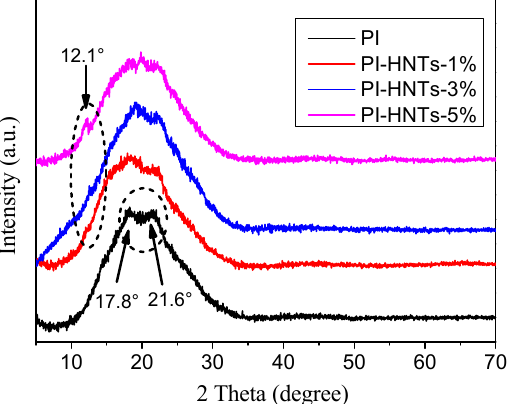
Figure 6. XRD patterns of PI, PI-HNTs-1%, PI-HNTs-3% and PI-HNTs-5%.